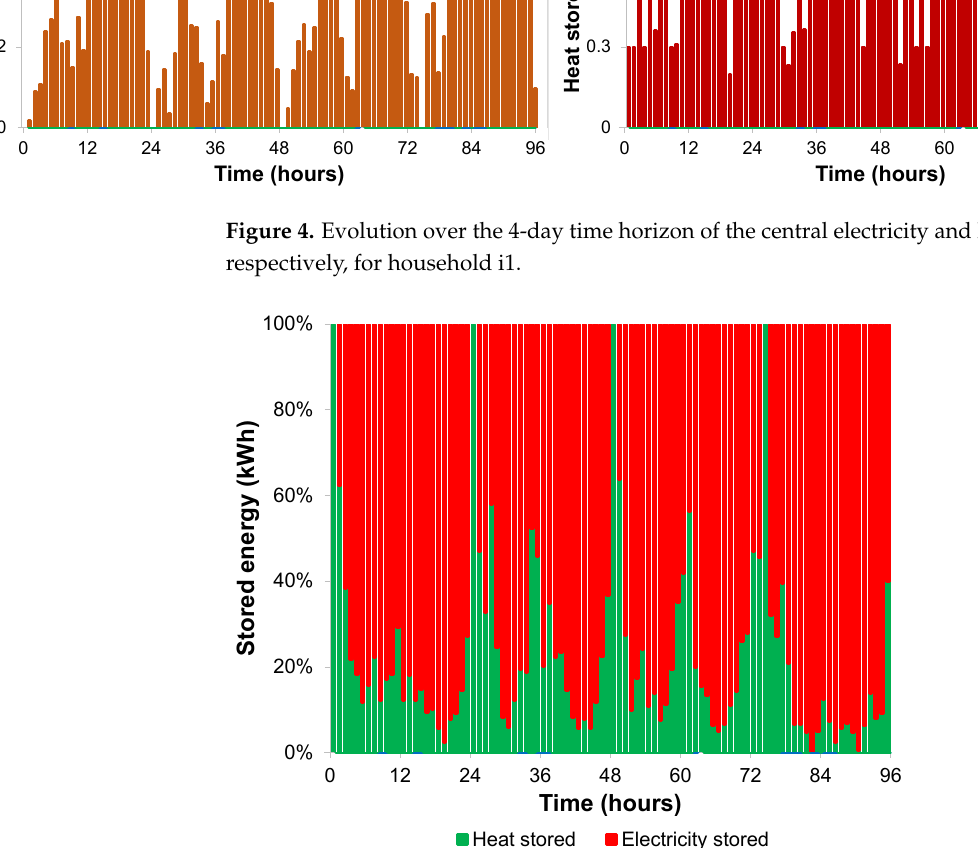
Figure 4. Evolution over the 4-day time horizon of the central electricity and heating storage content, respectively, for household i1.